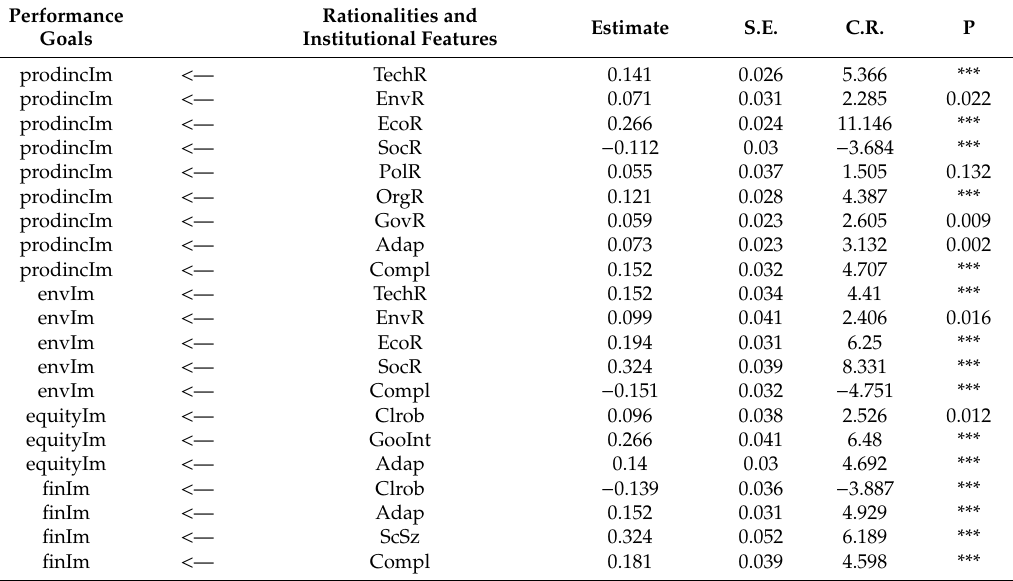
Table 6. Rationalities, institutional features, and performance (Pathway 2–3 and